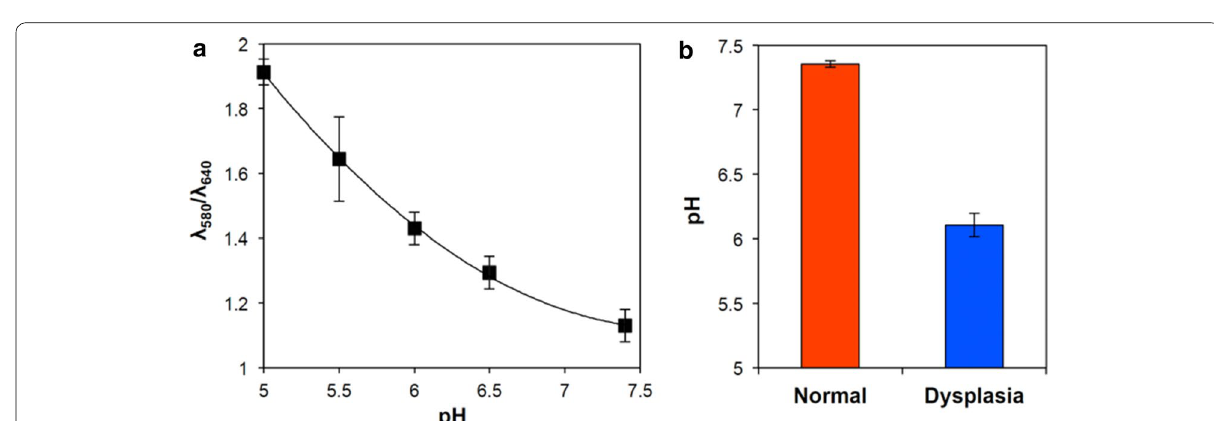
Fig. 5 Characterization of pH in normal and dyplastic tissue. pH‑dependent fluorescence ratios of Au NC‑SNARF at 580 and 640 nm wavelengths (λ 580 nm /λ 640 nm ) at various pHs (standard curve) ( a ) and pHs in normal (applied with mineral oil alone) and oral dysplastic (applied with DMBA in mineral oil) tissues, determined by topically applying Au NC‑SNARF using multi‑modal delivery methods and comparing resultant fluorescence ratios by confocal microscopy at 580–640 nm wavelengths in the tissues using confocal microscopy ( b